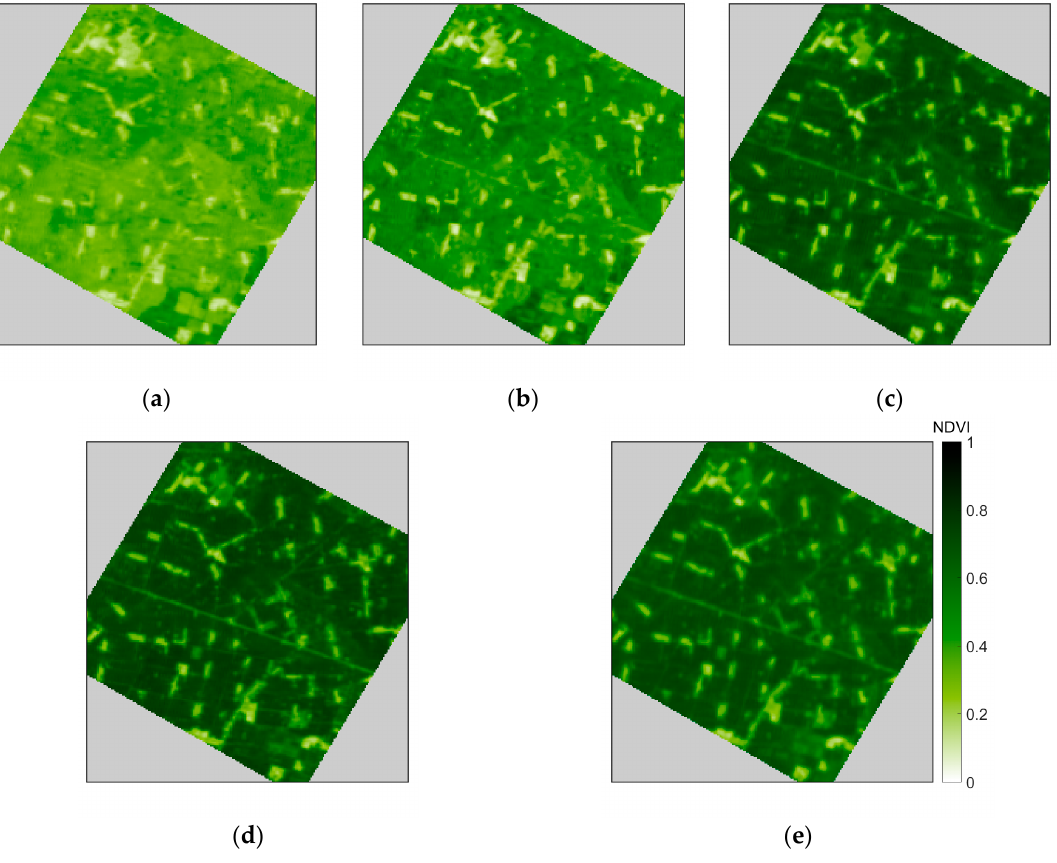
Figure 2. Five available NDVI maps from 10 June 2012 to 15 July 2012: ( a ) is on 15 June; ( b ) is on 19 June; ( c ) is on 29 June; ( d ) is on 8 July; and ( e ) is on 13 July.